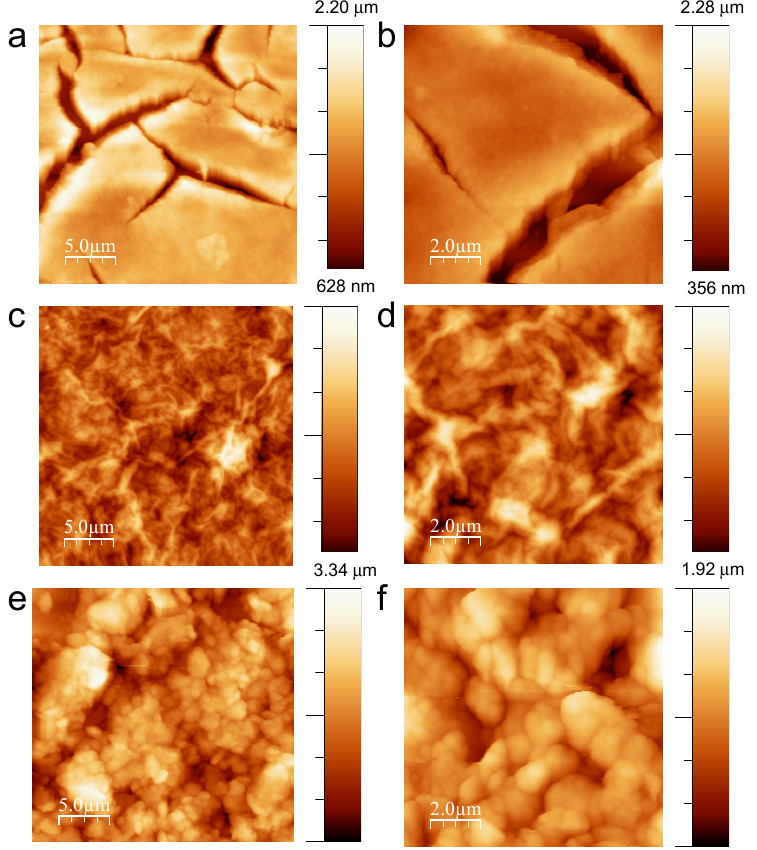
Figure 4. Non-contact-mode AFM images (( a , c , e ): 25 μ m × 25 μ m and ( b , d , f ): 10 μ m × 10 μ m) on: GL film ( a , b ); GO-GRA film ( c , d ); GO-SA film ( e , f ).